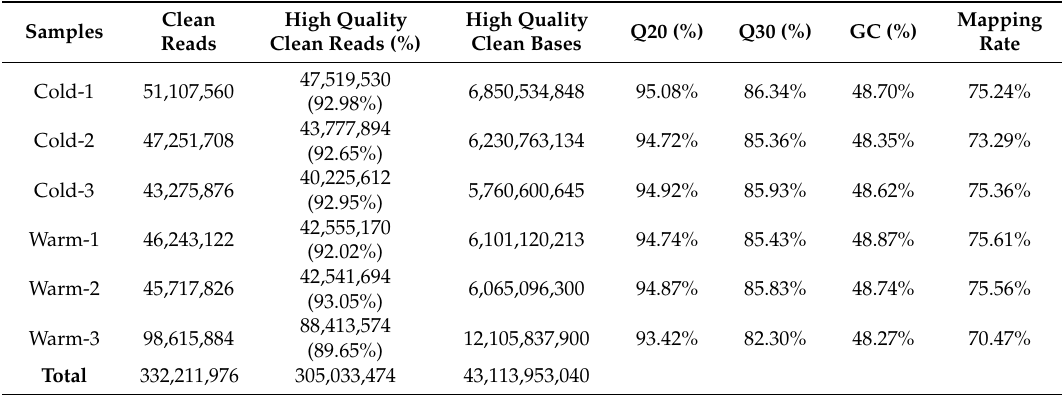
Table 1. Statistics analysis of RNA sequencing data from low-temperature-treated and CK